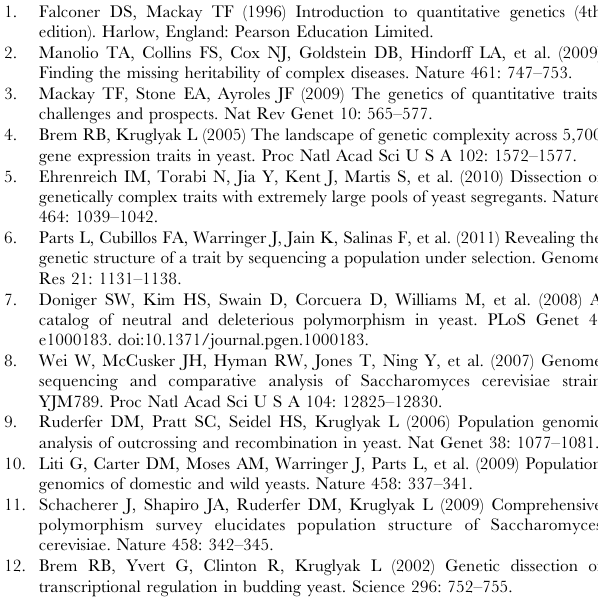
Table S1 All patterns used to identify allelic singletons and allelic doubletons in the X-QTL data, and the number of loci detected with these patterns. The strain mentioned under a cross indicates which allele should have been selected in that cross for the given pattern to hold. We show all exact patterns used to identify singletons and doubletons, as well as each of the patterns that indicate the presence of a singleton or doubleton if one undetected peak is allowed. Both the exact match and ‘‘one off’’ patterns were used in the counts of bi-allelic loci described throughout the paper. (DOC) Table S2 Allelic series inferred from the data. The most parsimonious relationship of alleles to each other is indicated. Greater than and equal signs indicate the effects of the alleles relative to each other, with ‘‘A . B’’ meaning that allele A confers higher resistance than allele B and ‘‘A= B’’ meaning that the effects of allele A and allele B are not distinguishable. In some cases, there are two equally parsimonious relationships that can explain the data. (DOC) Text S1 Formulae used to estimate the detection rate ( a ) and the ratio of allelic singletons to doubletons ( b